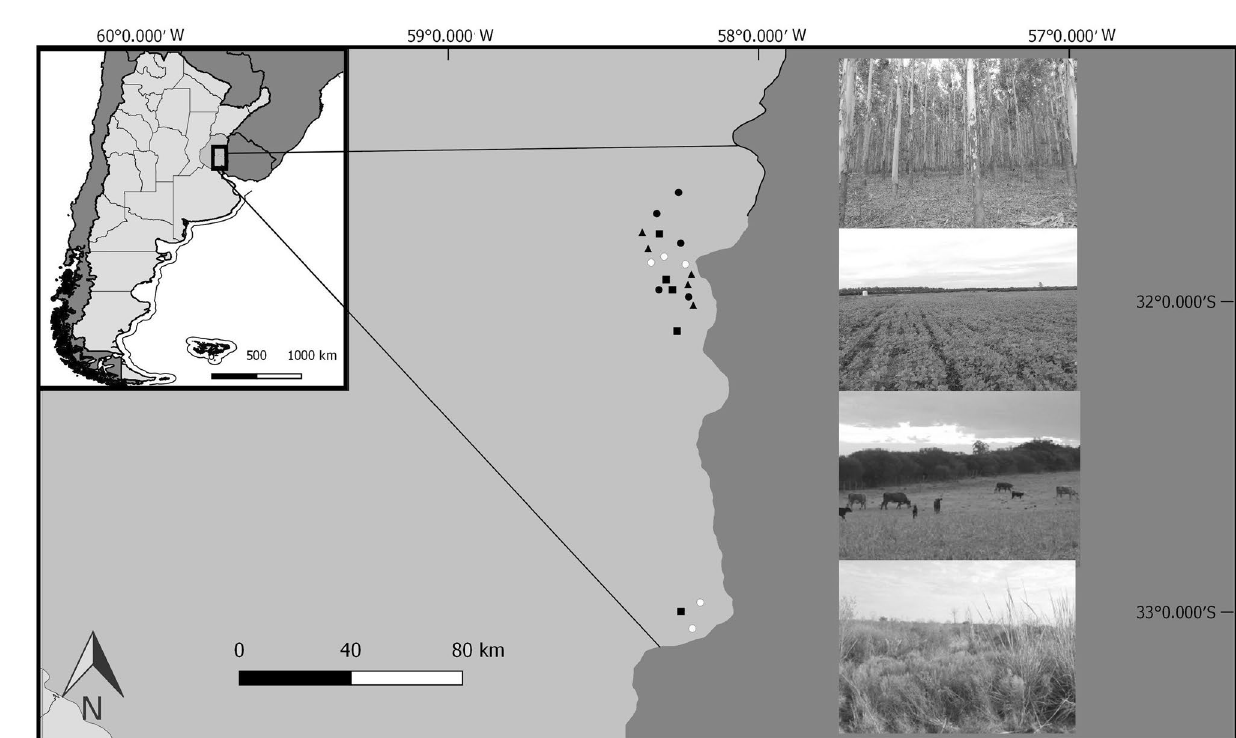
Figure 1. Study sites in the central-eastern Argentina. Black circles represent eucalypt plantations, white circles are protected natural grasslands, triangles are cattle fields and squares are soybean crops fields. On the right there is a representative picture of each land-use type, from the top to the bottom first eucalypt tree plantation, then soybean crop field, cattle field and natural